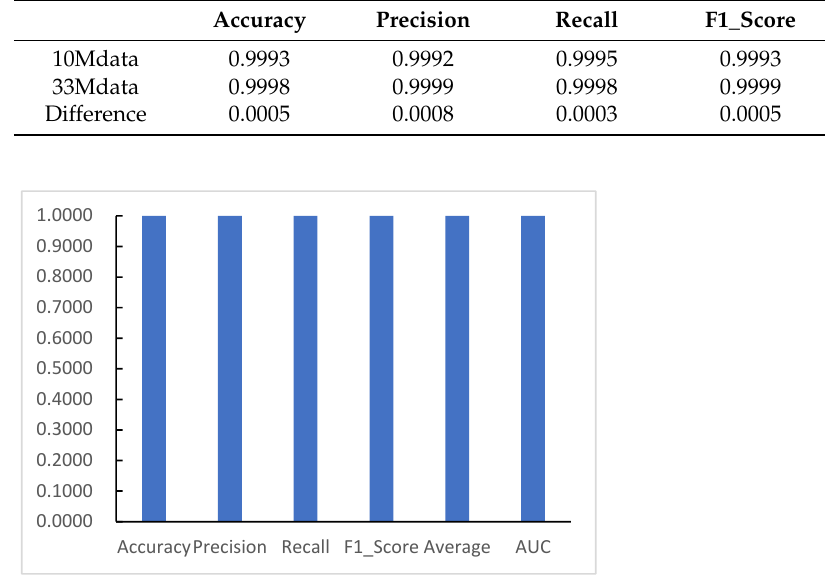
Table 13. Performance metrics for generalization capability of changing DDoS dataset.